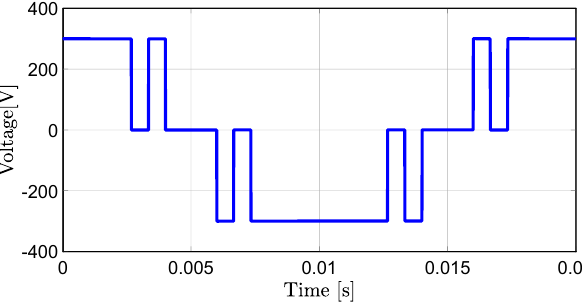
Figure 4. ( a ) Gate to source voltage to Q1, Q2; ( b ) Gate to source voltage to Q3, Q4.